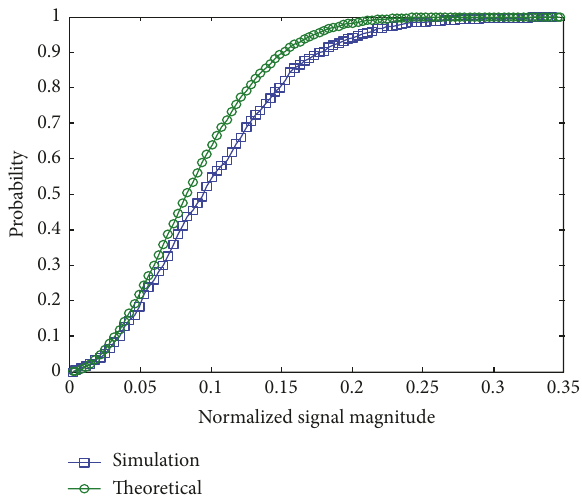
Figure 7: Comparison of theoretical Rayleigh and simulated CDF.